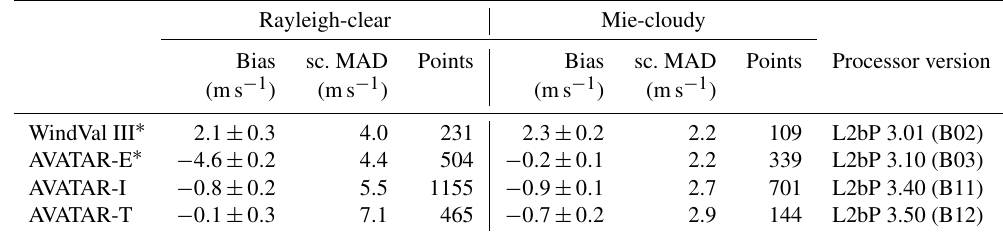
Table 3. Aeolus systematic and random error determined from different campaign data sets.